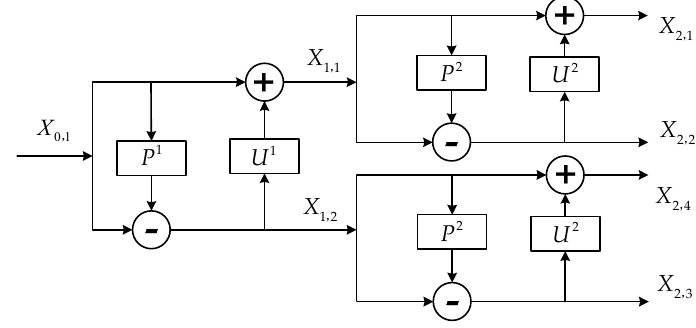
Figure 2. An example of two levels RSGWPT decomposition stage.